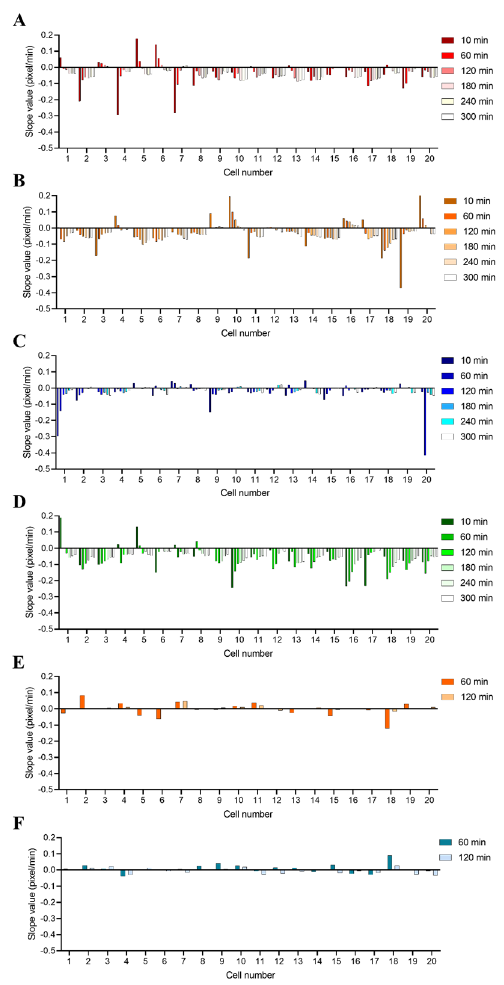
Figure 20. The slopes of the decrease in the total displacement of 20 cells as a function of time were calculated based on the time points 10, 60, 120, 180, 240, and 300 min during 0.5 µ g/mL caspofungin or fluconazole treatment of the C. albicans strains: ( A ) Caspofungin-treated CAF2 − 1, ( B ) Fluconazole- treated CAF2 − 1, ( C ) Caspofungin-treated DSY1024, ( D ) Fluconazole-treated DSY1024 during the 2 h growth in YDP medium ( E ) CAF2 − 1 and ( F )